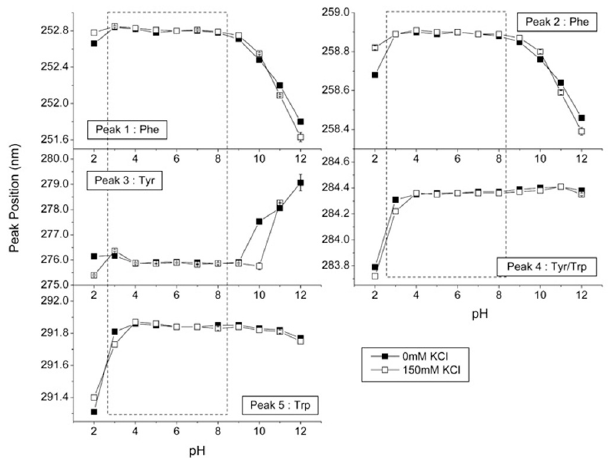
Figure 8. Second derivative UV–Vis spectra for IgG. The effect of different pH is presented for five characteristic peaks. Reproduced with permission from [76], Elsevier, 2008.